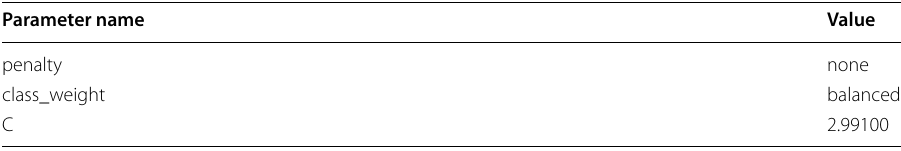
“None” value indicates default value of hyperparameter is optimal; parameter values for classifier yielding best results in terms of AUPRC Table 98 Modes of LR tuned hyperparameter values for experiments with the keylogging dataset